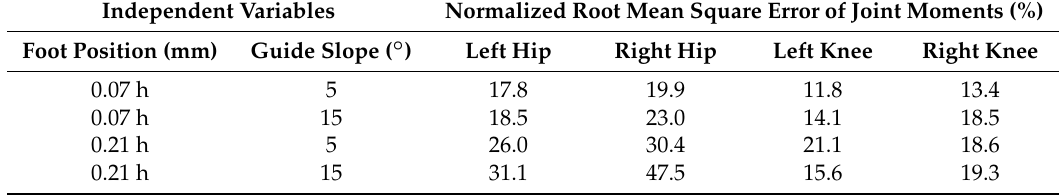
Table 8. NRMSEs of measured and simulated joint moments.